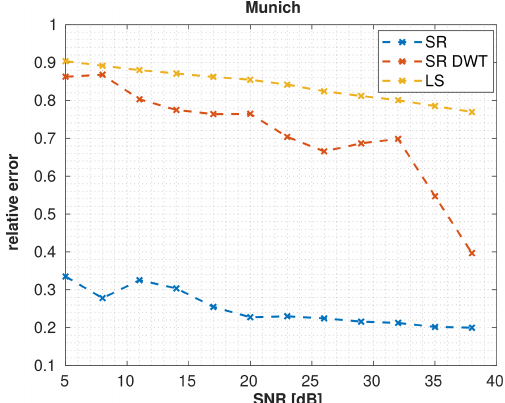
Figure 9. Reconstruction errors of SR in the spatial and wavelet domain as well as LS for Munich when varying the SNR and m 1 .